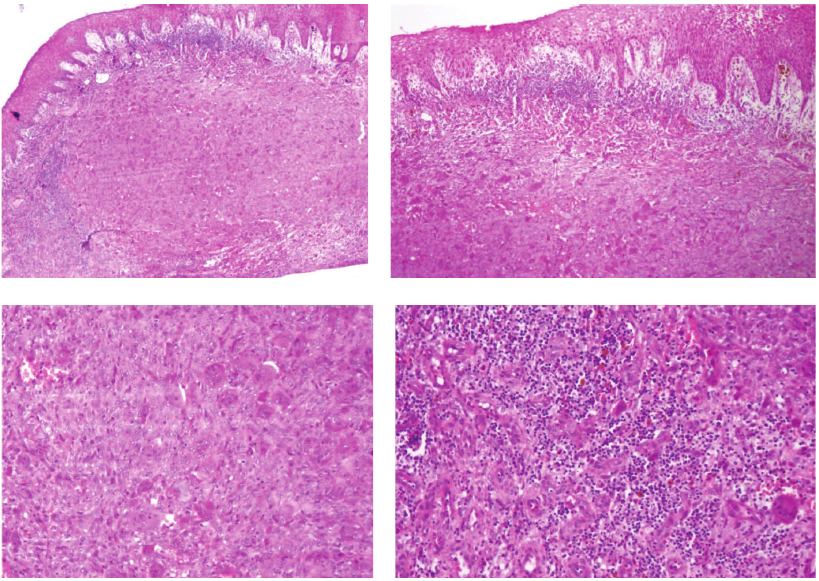
Figure 5: Histopathology of peripheral giant-cell